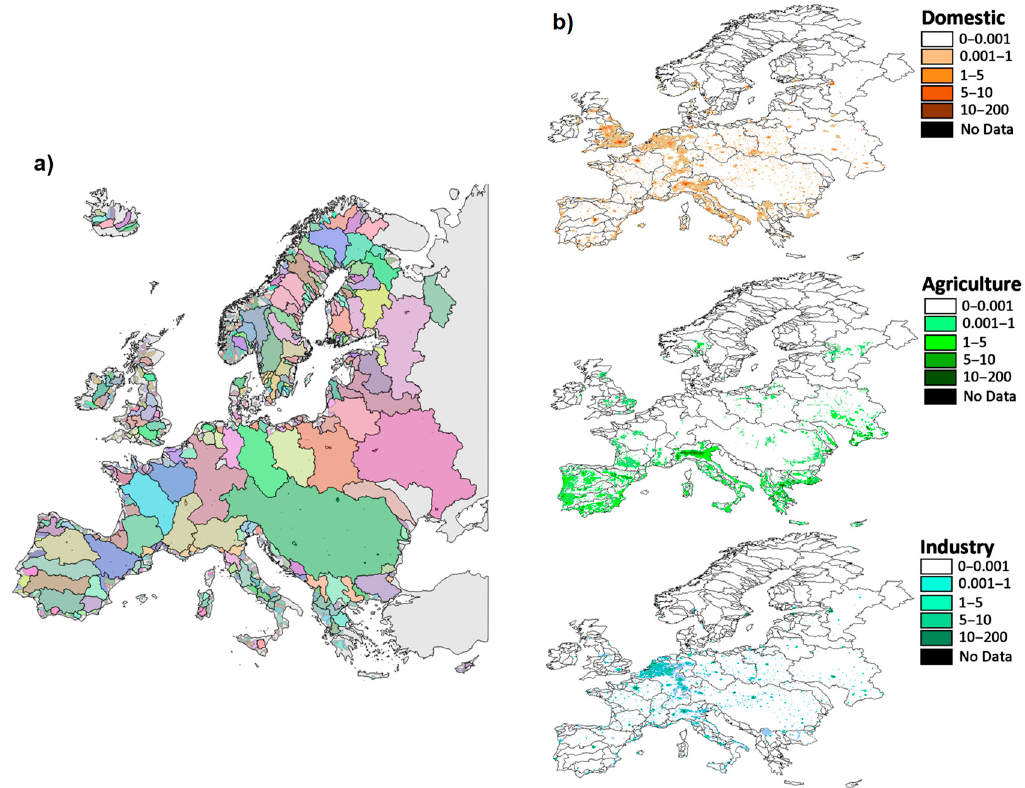
Figure 3. Case study: Western Europe. ( a ) Domain under analysis. Colours represent the 621 major river basins draining to the sea. ( b ) Information utilized for the estimation of withdrawals (domestic (hm 3 /km 2 ), agriculture (hm 3 /km 2 ) and industry (hm 3 /km 2 )) in present and future scenarios and for each analysed sub-basin.